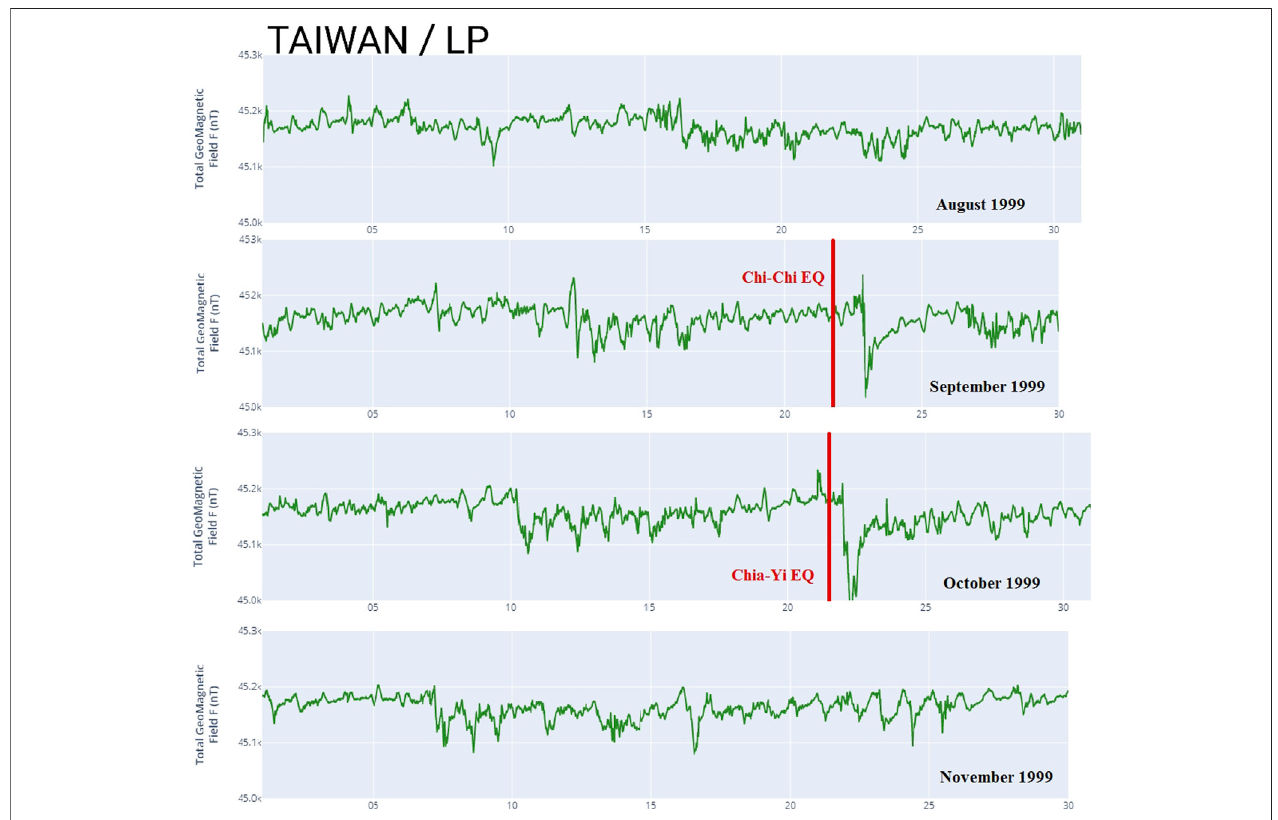
FIGURE 1 | Geomagnetic total intensity data recorded at the reference station (LP) from August to November 1999 adapted from Yen et al. (2004).